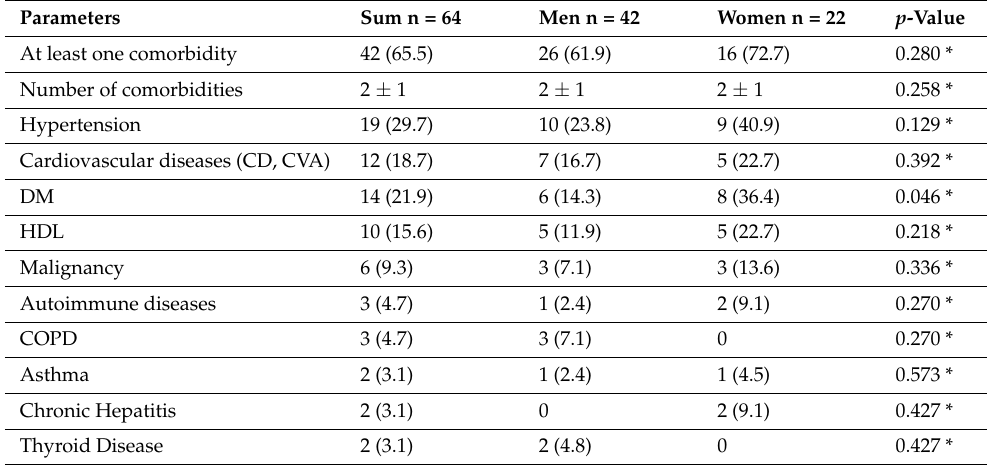
Table 2. Comorbidities of the study’s population and their comparison based on sex, n =